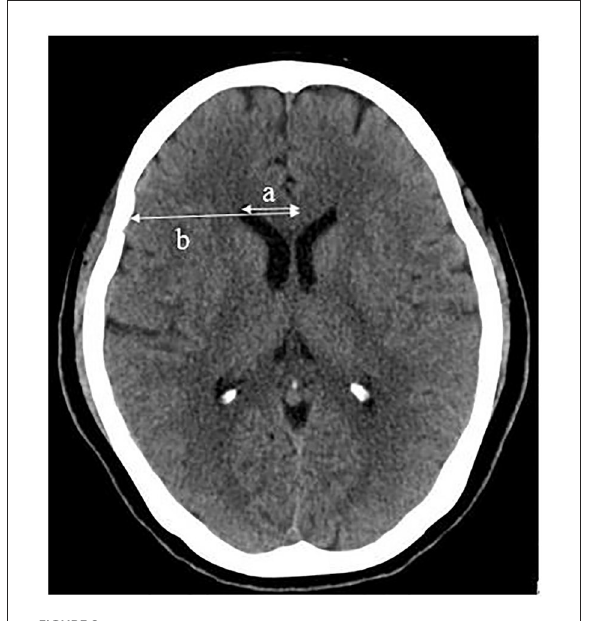
FIGURE2 Frontal ratio (%) = a/b × 100, (a: distance from the frontal angle of the lateral ventricle to the cerebrum falx; b: width of the corresponding horizontal frontal